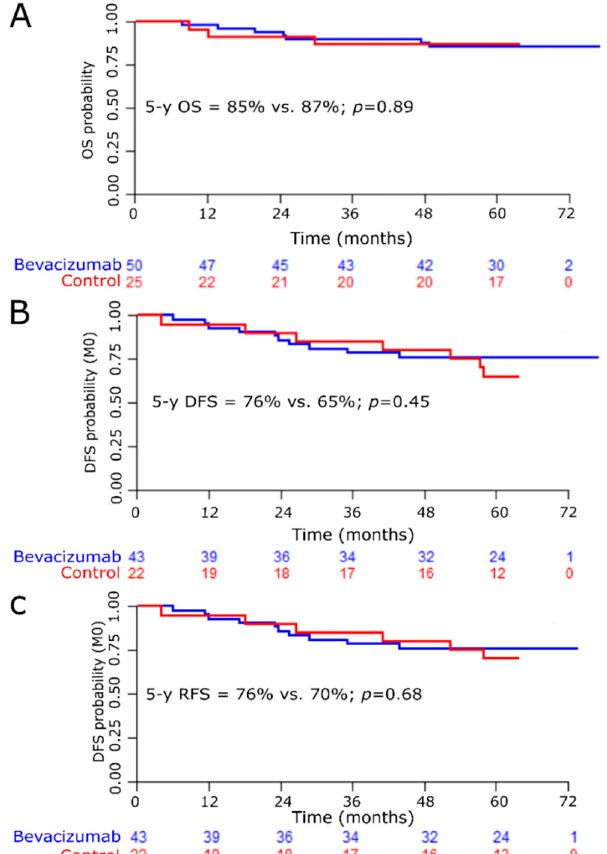
Figure 3. Kaplan–Meier curves. ( A ): Overall survival for the whole cohort. ( B ): Disease-free survival for non-metastatic patients. ( C ): Relapse-free survival for non-metastatic patients.